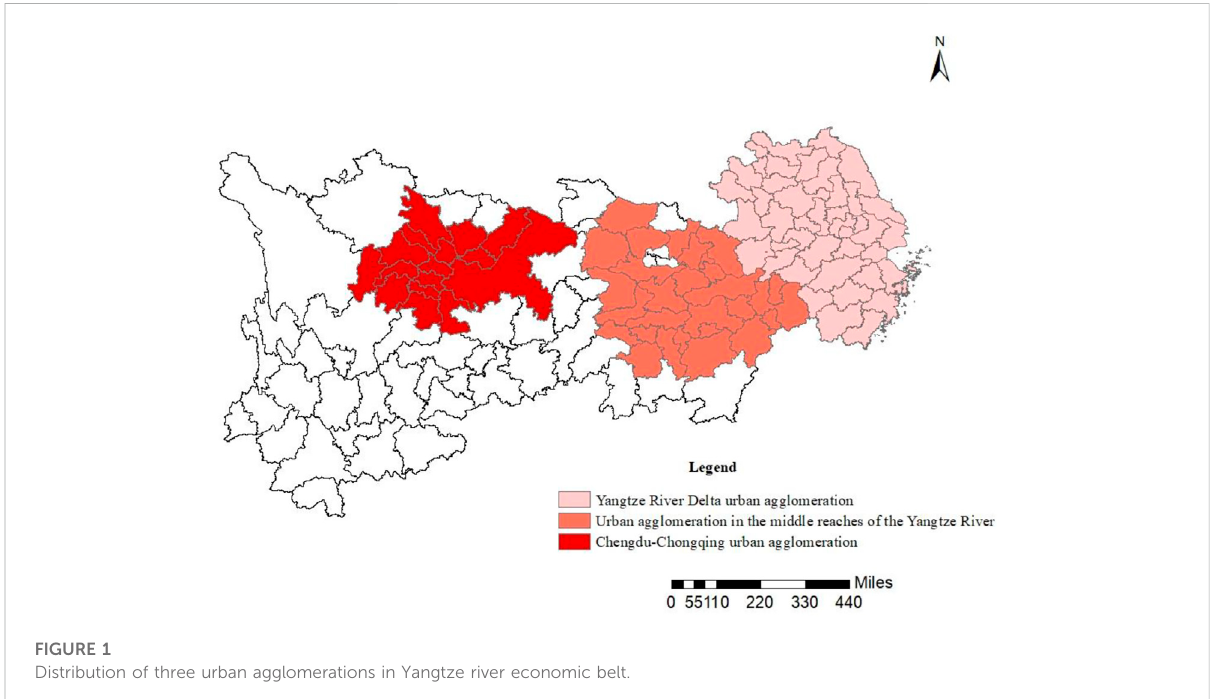
FIGURE 1 Distribution of three urban agglomerations in Yangtze river economic belt.